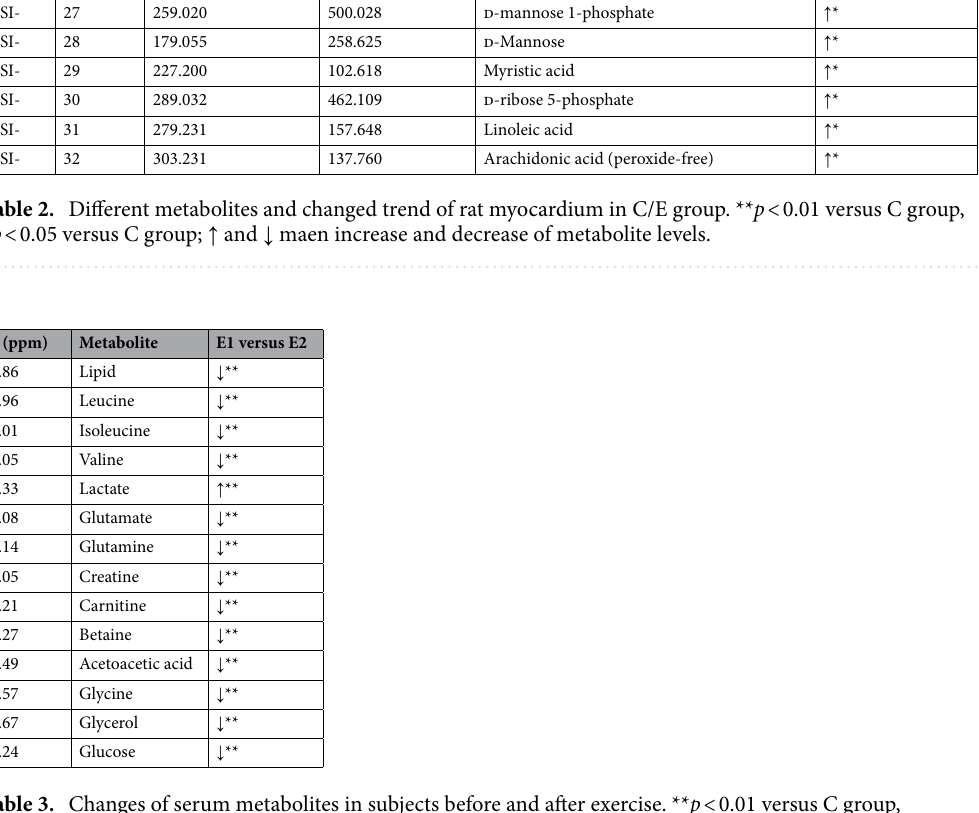
Table 3. Changes of serum metabolites in subjects before and after exercise. ** p < 0.01 versus C group, * p < 0.05 versus C group; ↑ and ↓ means increase and decrease of metabolite